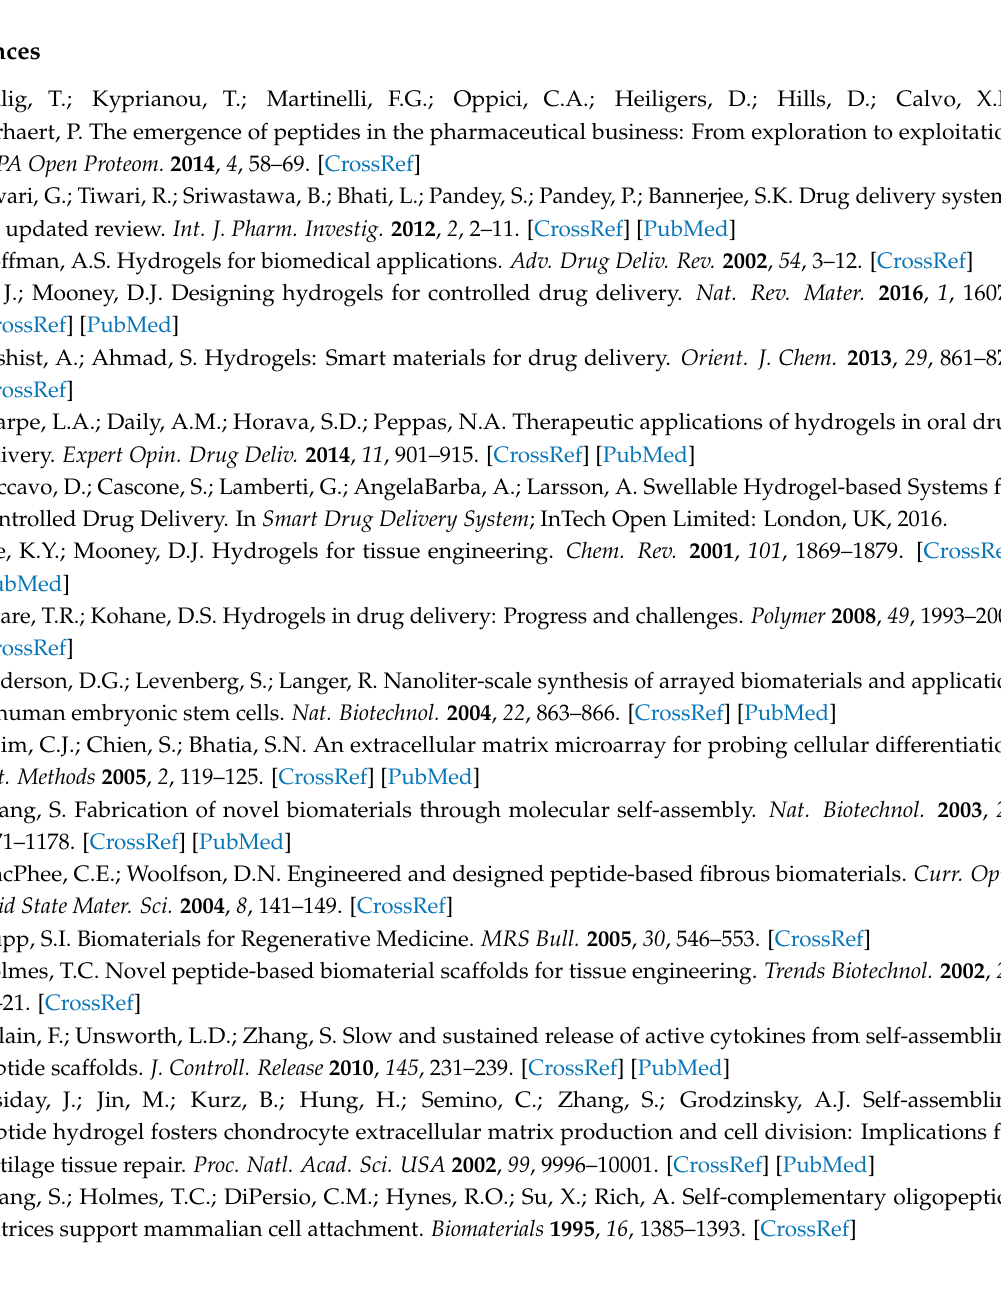
Figure S1: Representative (i) HPLC (i) and (ii) MALDI TOF/TOF mass spectrometry (ii) of purified peptide (RADA) 4 , (RADA) 4 -GG-GPQG+IASQ, and (RADA) 4 -GG-GPQG+PAGQ, shown in A, B, and C, respectively. Purities were determined to be above 95% by measuring the comparative areas under the major curve in the HPLC spectra. Major peaks in the MALDI spectra are at 1671.8, 2525.2, and 2478.8 m/z which reflect the theoretical molecular weights. All peaks were normalized to their respective